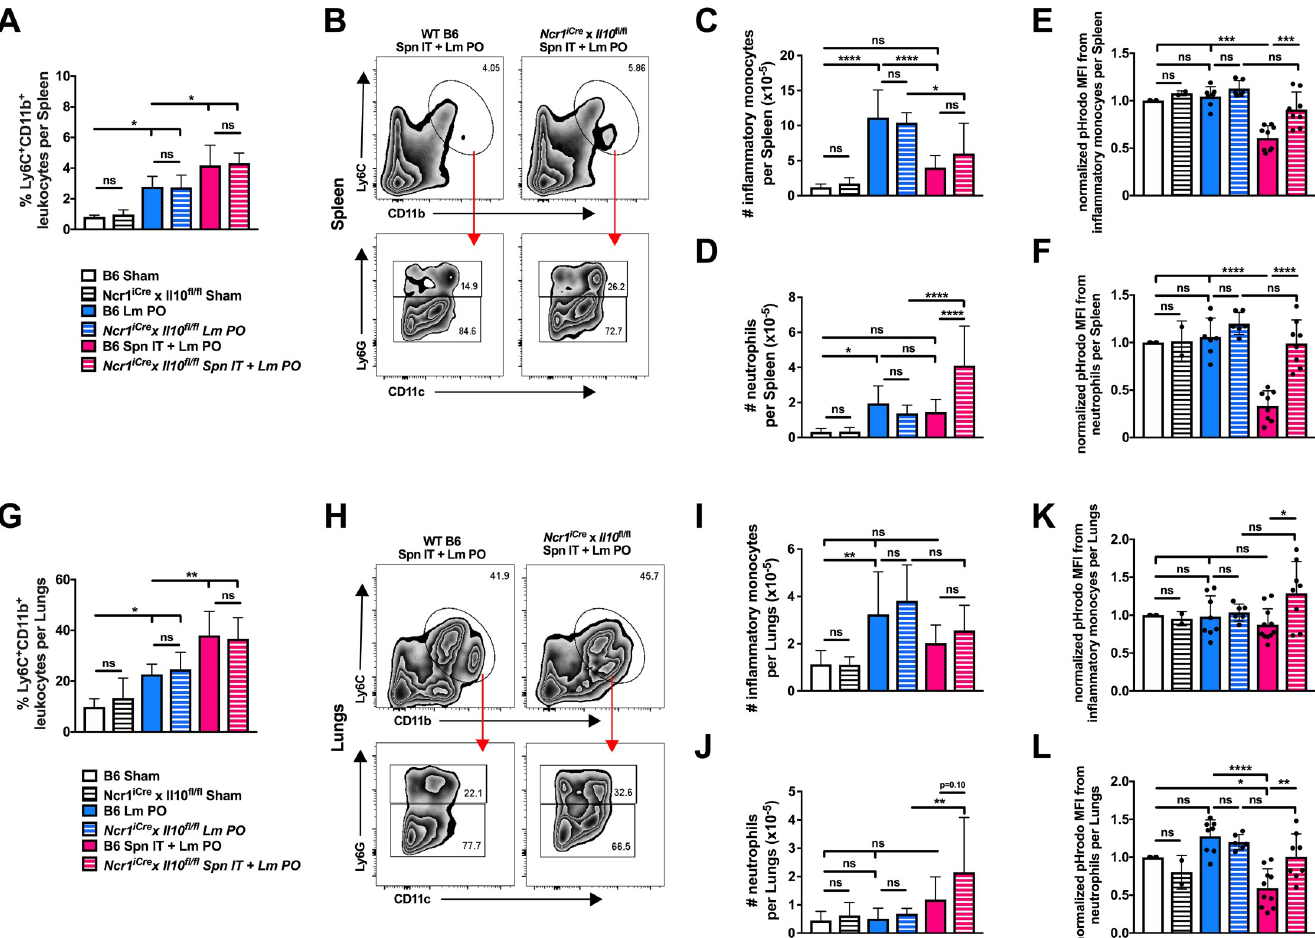
Fig 5. IL-10 from Ncr1+ cells limits myeloid cell accumulation and phagocytic capacity during coinfection . C57BL/6J (B6) and Ncr1 iCre x Il10 fl/fl male and female age- matched mice were infected with sham control, Lm PO, or Spn IT + Lm PO and harvested at 3 dpi. Quantitation of percent CD45.2 + Ly6C + CD11b + leukocytes in (A) spleens and (G) lungs. Data represent mean ± SD, One-way ANOVA, pooled from 3 experiments, 6–12 mice per group, � p < 0.05, �� p < 0.002 between indicated groups. Representative flow plots of Ly6G + neutrophils and Ly6G - CD11c l ˚ inflammatory monocytes in B6 and Ncr1 iCre x Il10 fl/fl coinfected mice in (B) spleens and (H) lungs. Quantitation of total number of CD45.2 + Ly6C + CD11b + cells that are Ly6G - CD11c l ˚ inflammatory monocytes in spleens (C) or Ly6G + neutrophils in spleens (D) or that are Ly6G - CD11c l ˚ inflammatory monocytes in lungs (I) or Ly6G + neutrophils in lungs (J). Data represent mean ± SD, One-way ANOVA, pooled from 3 experiments, 6–12 mice per group, � p < 0.05, �� p < 0.002, ���� p < 0.0001 between indicated groups. pHrodo S . aureus Bioparticles were incubated for 1 hr with cells isolated from spleens and lungs. Normalized mean fluorescent intensity (MFI) of pHrodo positive inflammatory monocytes and neutrophils was determined by flow cytometry. pHrodo MFI from inflammatory monocytes in spleens (E), neutrophils in spleens (F), inflammatory monocytes in lungs (K), and neutrophils in lungs (L). Data represent mean ± SD, One-way ANOVA, pooled from 2 experiments, 8–9 mice per group, � p < 0.05, �� p < 0.002, ��� p < 0.0002, ���� p < 0.0001 between indicated groups.